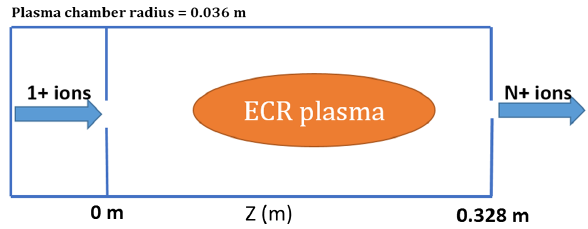
FIG. 3. MCBC simulation domain ( z ¼ 0 m to 0.328 m) with respect to the SP1 CB plasma chamber dimensions.